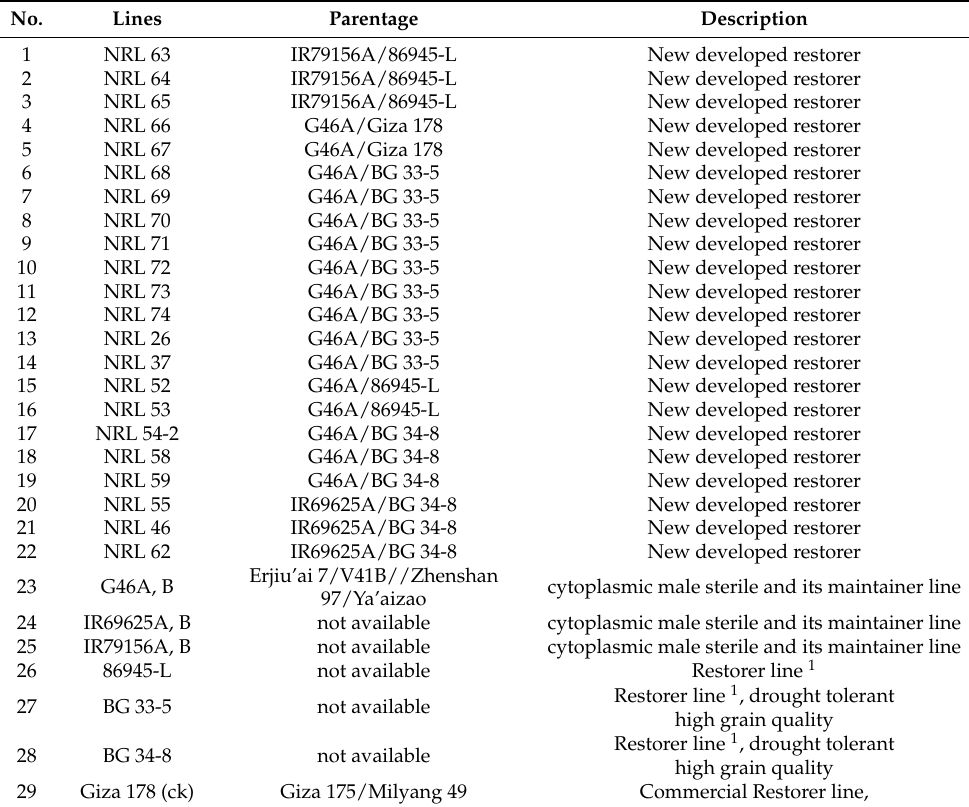
Table 1. Names and parentage of the selected genotypes under